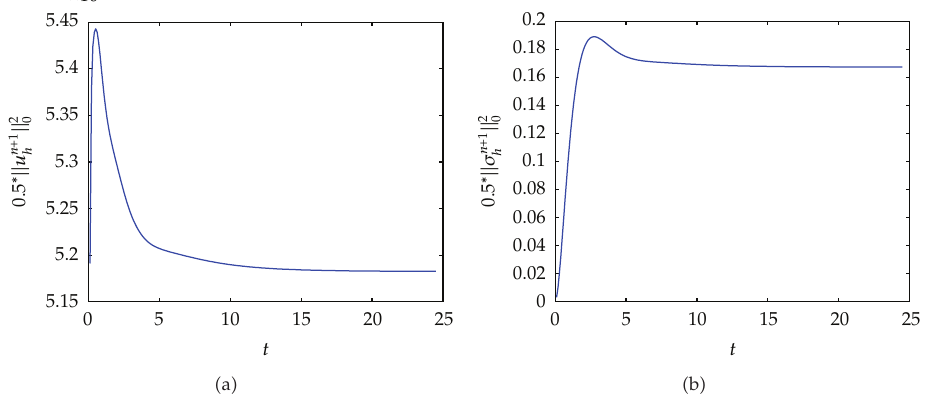
(cid:6) 2 / 2 (cid:2) a (cid:3) and (cid:6) σ n (cid:11) 1 h 0